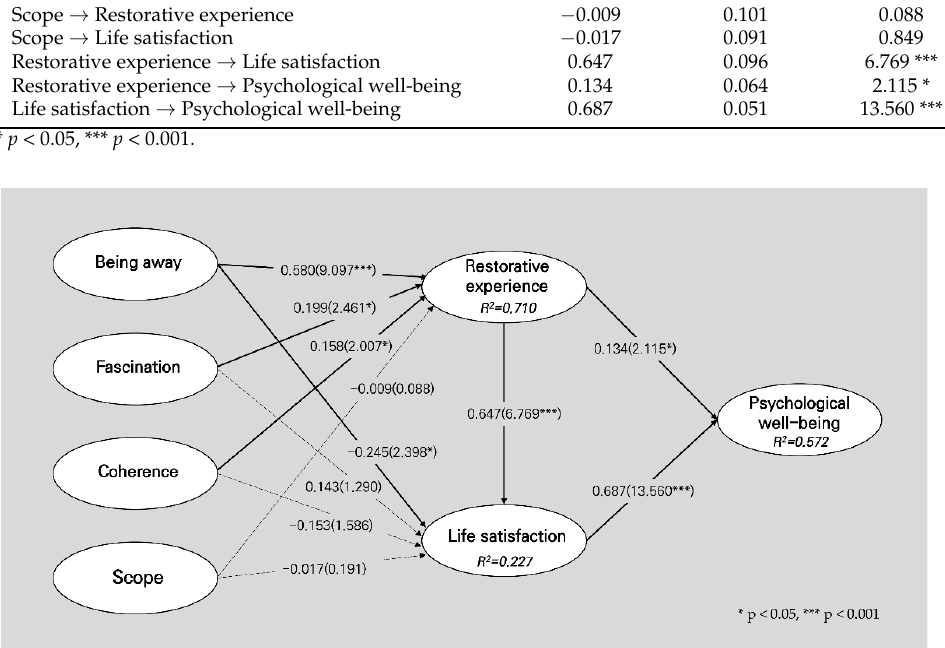
Figure 3. Hypothesis test